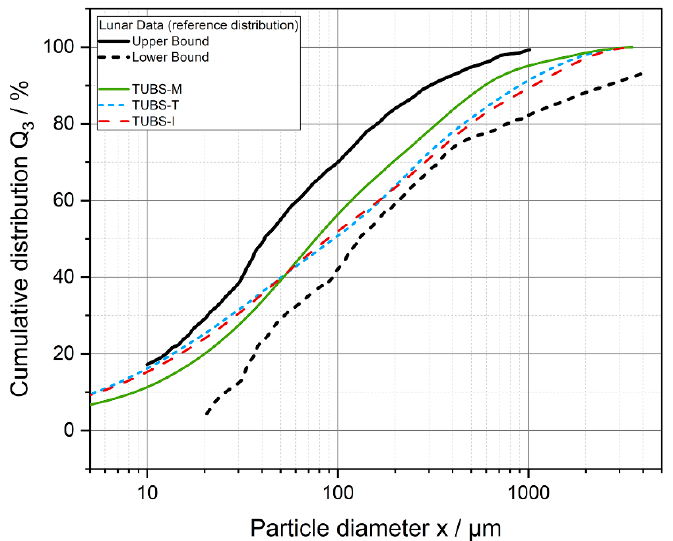
Figure 2. Particle size distribution (measured by Mastersizer 3000, Malvern Panalytical GmbH, Kassel, Germany) of the examined batch samples of TUBS-M, TUBS-T, and TUBS-I in the distribution band for Apollo 11, 12, 14, and 15, modified from [76]. Particle diameter equals particle size.